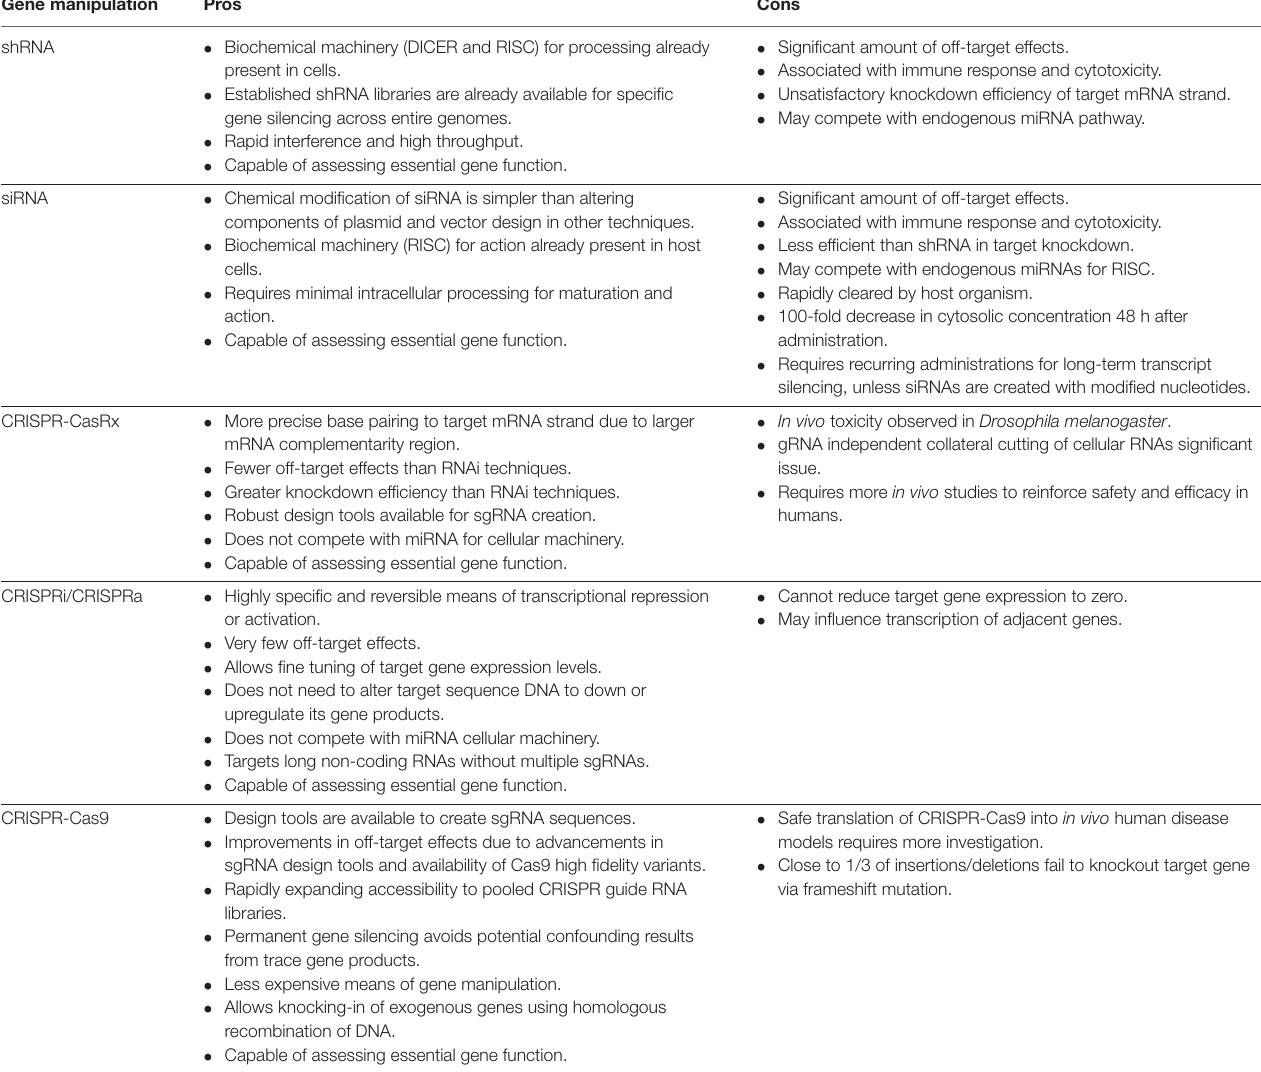
TABLE 2 | Pros and cons of various RNAi and CRISPR-Cas gene manipulation techniques. Gene manipulation Pros Cons